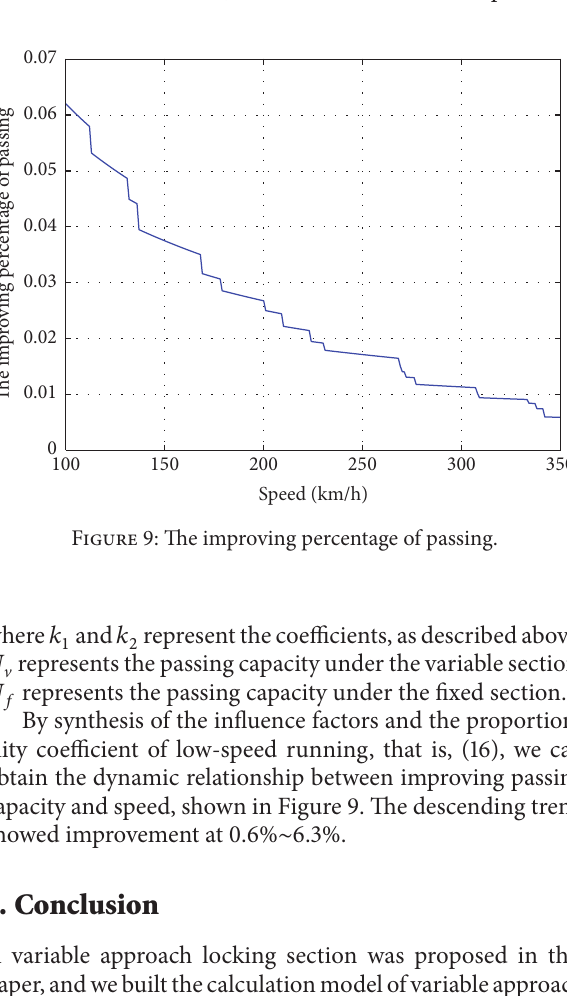
Types of arrival-departure can be divided into starting, arriving, passing, occupying, and turn-back events. The oper- ations of arrival, passing, and occupying involve handling the route, which in the study was 82.6% (set 𝑘 1 = 82.6 %) of the arrival-departure of Shaoguan station.